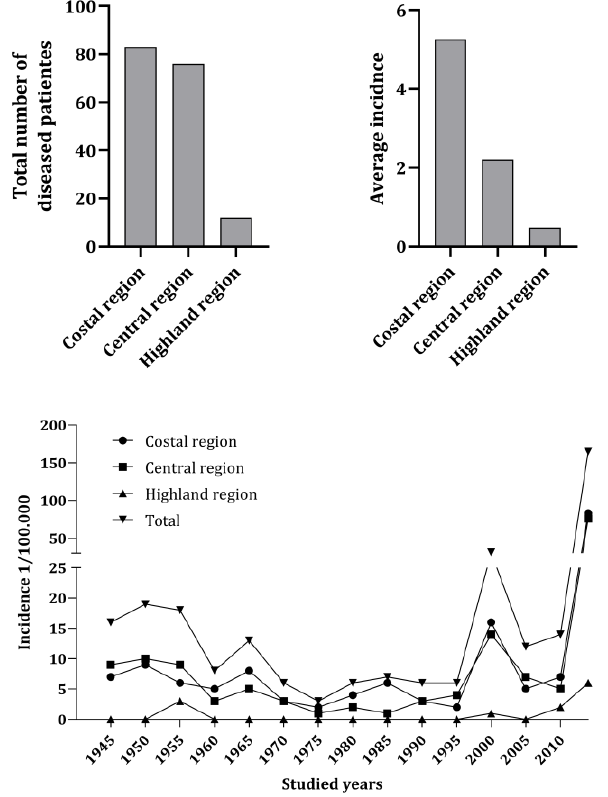
Figure 1. The number of the affected and average incidence rate of leishmaniosis by different regions in Montenegro in the period 1945 – 2014.